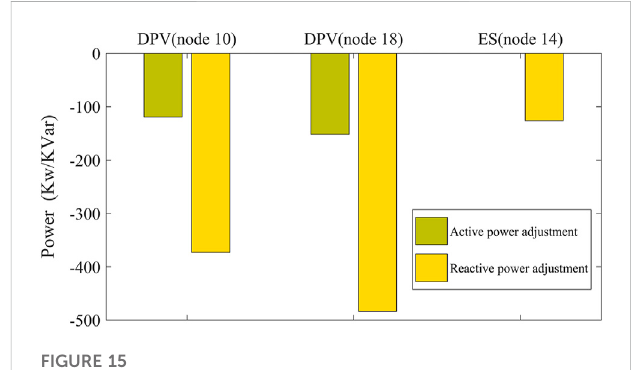
FIGURE 15 Power adjustments of each voltage regulation device.